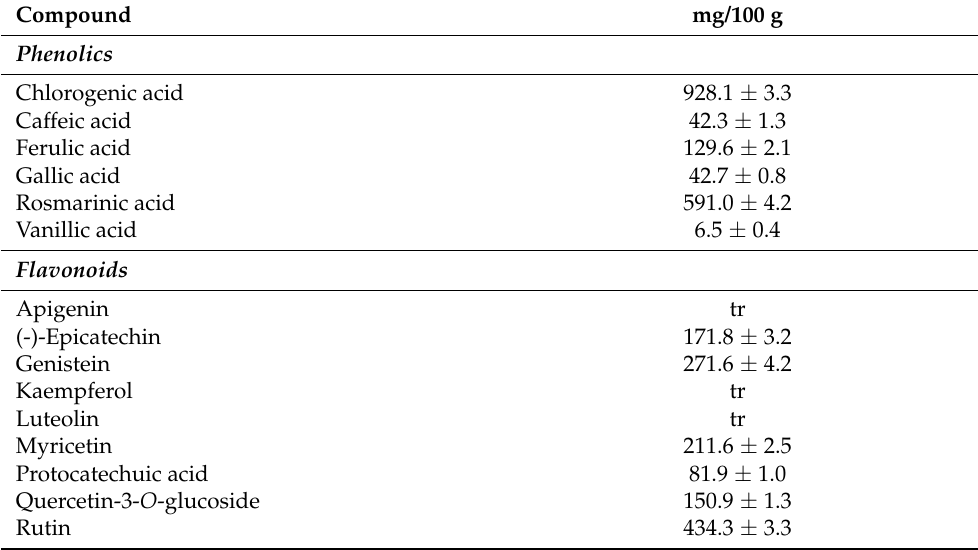
Table 1. The main identified compounds in the methanol extract of S. pinnata (EMSP). Compound mg/100 g